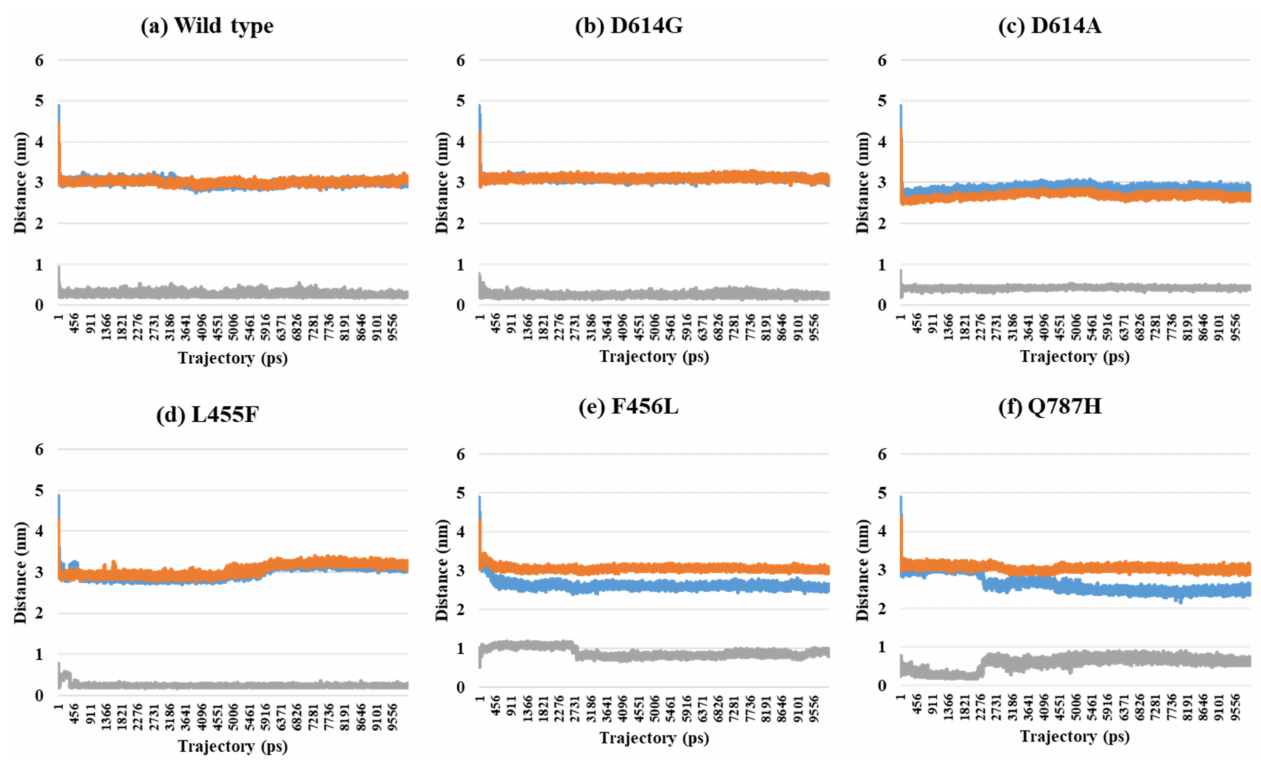
Figure 2. Distance between V503 residues in two chains depending on MD trajectories in the 1-open-complex form (7A94). ( a ) Wild type, ( b ) D614G, ( c ) D614A, ( d ) L455F, ( e ) F456L, and ( f ) Q787H. The X axis denotes trajectory (ps), and the Y axis denotes distance (nm). Blue color indicates the distance between A and B, orange indicates A–C distance, and gray indicates distance between B and C. Table 1. Summary of distance and SD between V503 residues (nm). The values were measured in the final trajectory (10 ns).